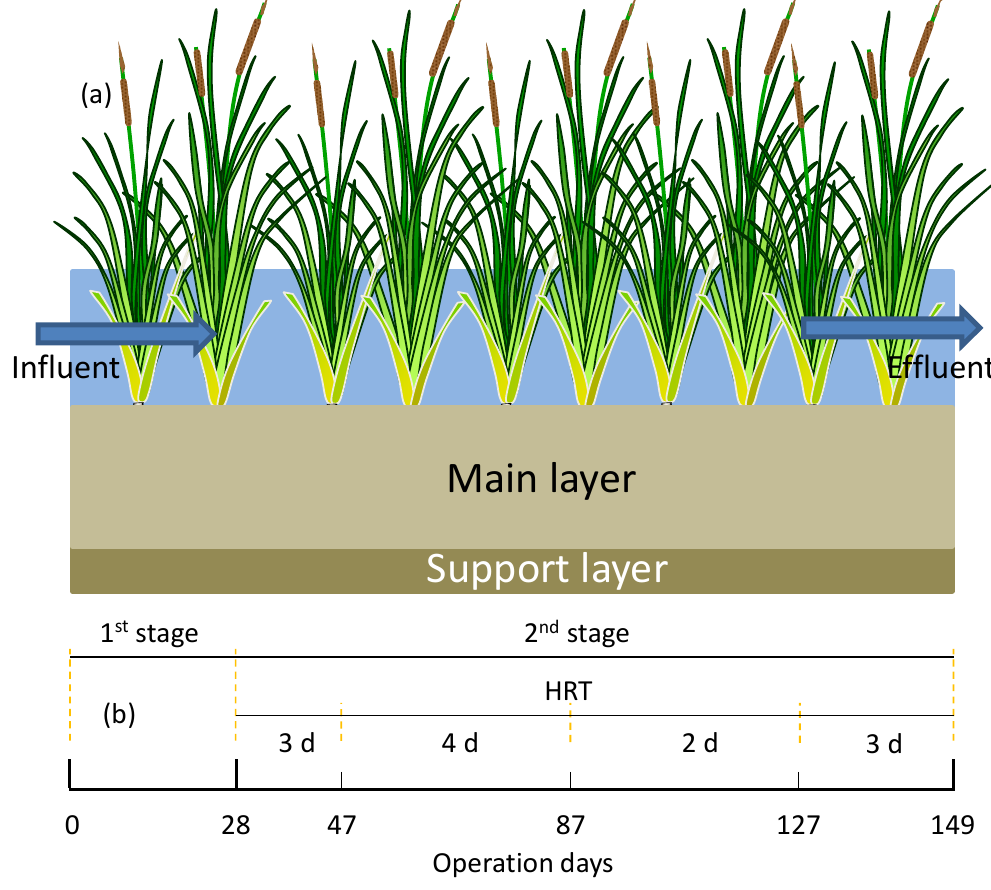
Figure 1. Schematic diagram of the reactor and the operation timeline. HRT—hydraulic retention time.